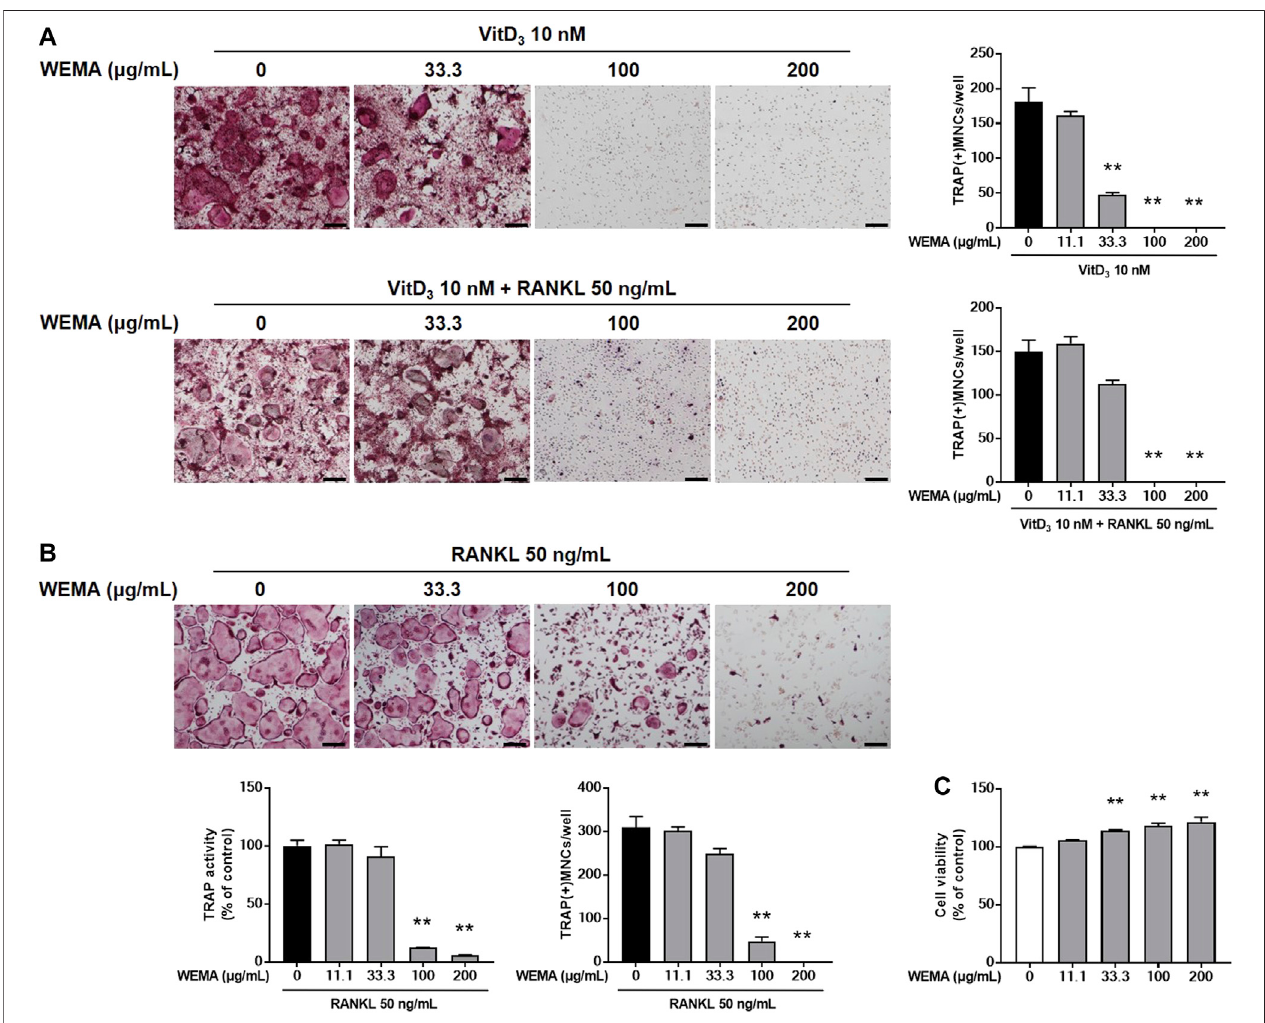
FIGURE 1 | WEMA inhibits osteoclast differentiation. (A) MLO-Y4 cells and BMMs were co-cultured with or without WEMA (11.1, 33.3, 100, and 200 μ g/ml) for 5 daysinthepresenceofVitD3 (10 nM)orVitD3(10 nM)plusRANKL (50 ng/ml).Representativeimages ofTRAPstaining(leftpanel;scalebar,200 µm)andthenumber of TRAP-positive MNCs containing three or more nuclei (right panel). (B) BMMs were cultured with or without WEMA for 4 days in the presence of RANKL (50 ng/ml). Representative images of TRAP staining (upper panel; scale bar, 200 µm), TRAP activity (lower left panel), and the number of TRAP-positive MNCs (lower right panel) containing three or more nuclei. (C) BMMs were incubated with or without WEMA (11.1, 33.3, 100, and 200 μ g/ml) for 24 h. Cell viability was evaluated by Cell Counting Kit-8 assay. Values are the mean ± SD of one representative experiment out of three with similar results, performed in triplicates. ** p < 0.01 versus